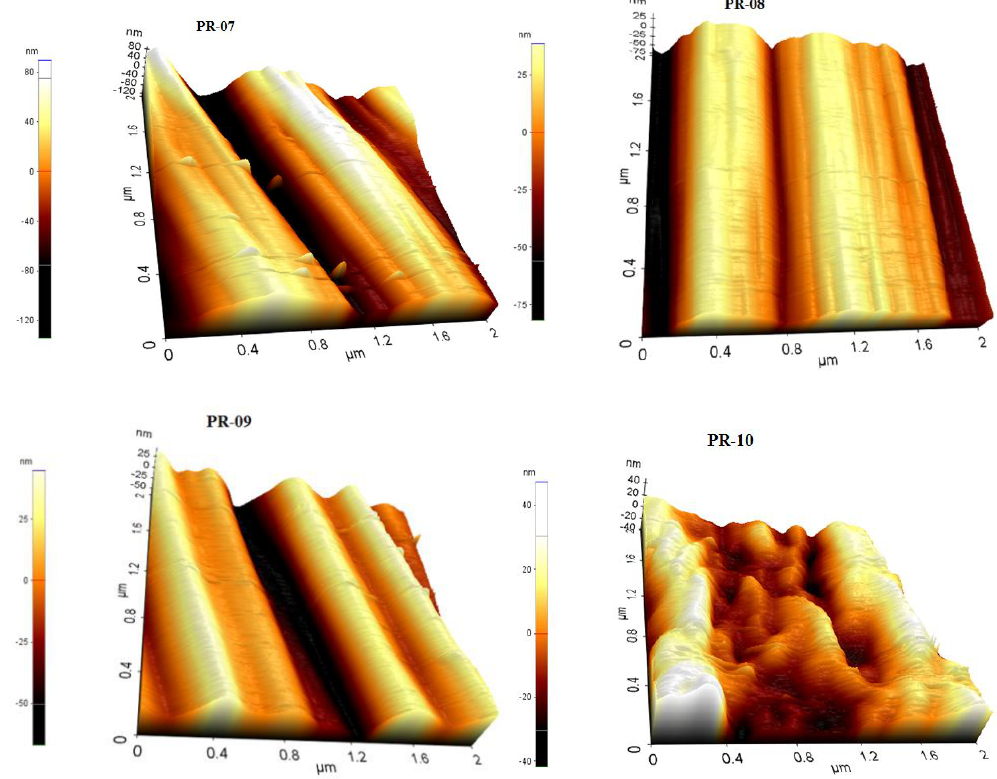
Figure 12. AFM images of blended PVDF membranes films prepared in solvents mixtures .